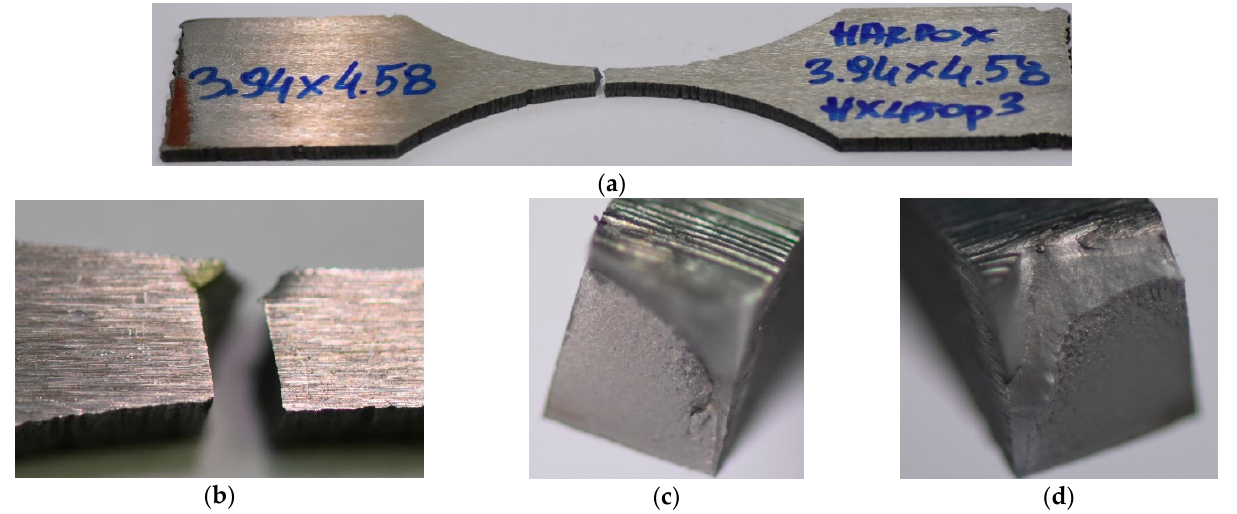
Figure 10. Hardox 450 with MAG weld from the fatigue test under the maximum value of stress equal to 511 MPa, ( a , b ) directly after separation, and ( c , d ) fracture region.